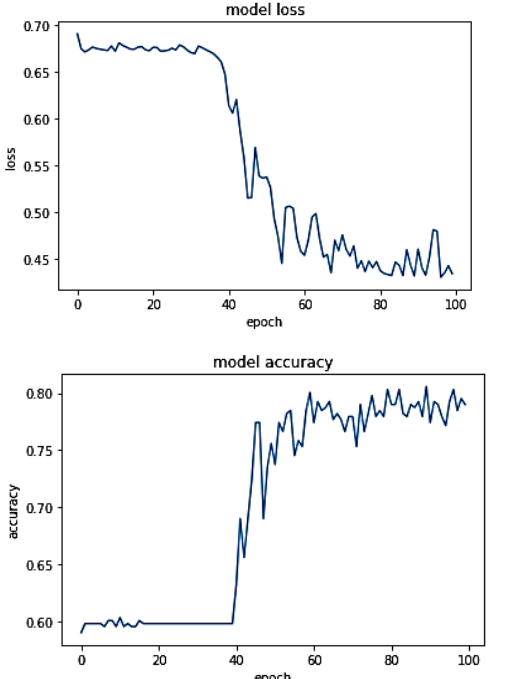
Fig. 4. Loss and accuracy plot of stacked LSTM model obtained over epochs.